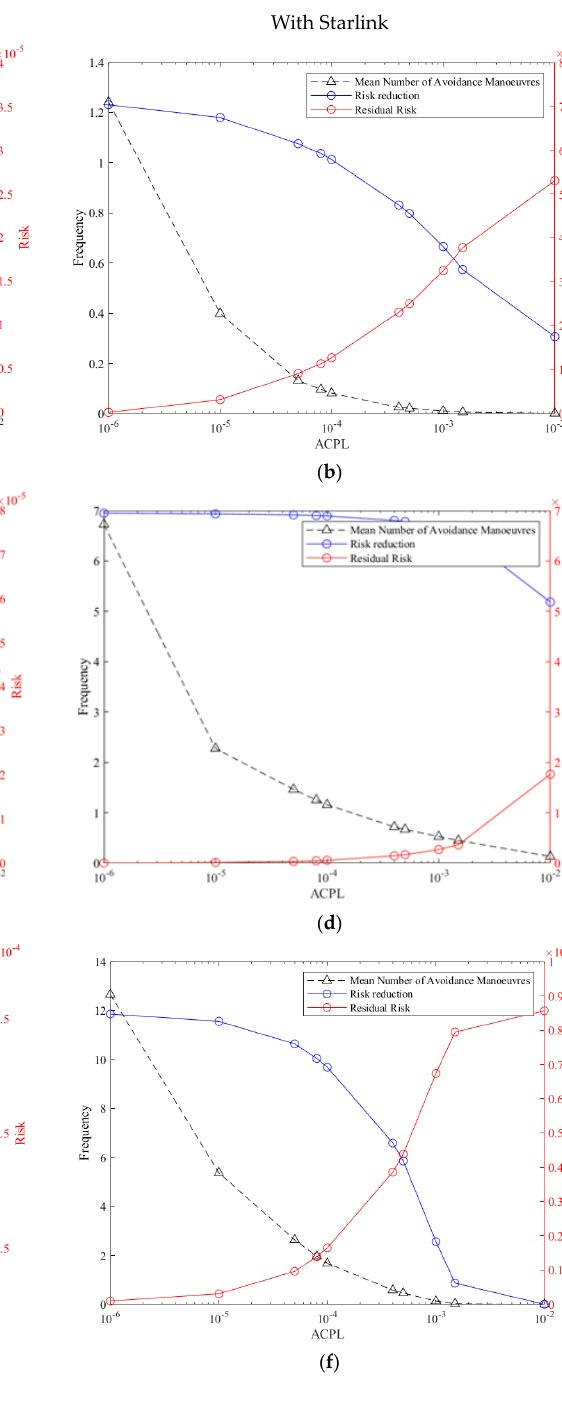
Figure 7. Comparison of ACPL values and average maneuvering coefficients for satellites with and without Starlink constellation. ( a , b ) The variation of GAOFEN satellites in the frequency and risk to different ACPL values With Starlink and Without Starlink; ( c , d ) The variation of CORVUS BC5 satellites in the frequency and risk to different ACPL values With Starlink and Without Starlink; ( e , f ) The variation of YAOGAN-35C satellites in the frequency and risk to different ACPL values With Starlink and Without